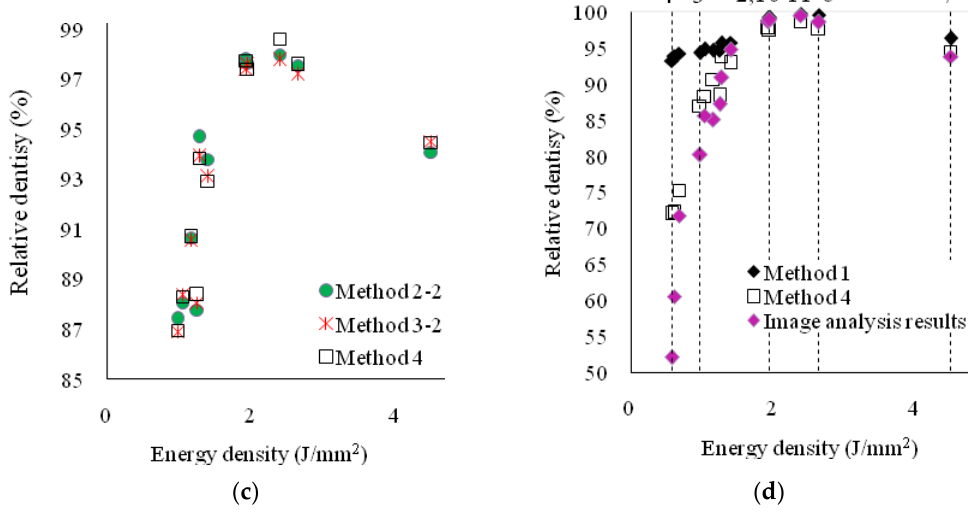
Figure 2. Comparison of results of relative density using different methods: ( a ) comparison of method 2-1and method 2-2; ( b ) comparison of method 3-1, method 3-2; ( c ) comparison of method 2-2, method 3-2 and method 4; and ( d ) comparison of method 1, method 4, and image analysis.